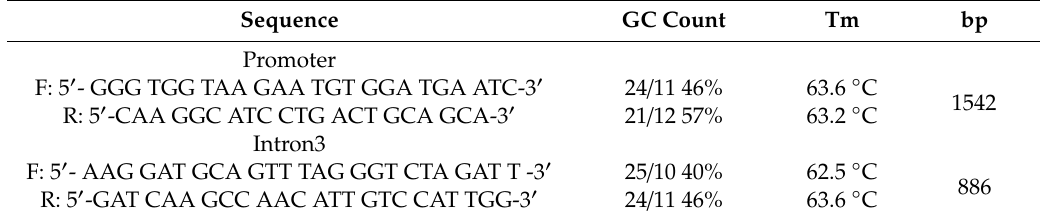
Table 1. The CD28 primers used in this study. F: forward primer; R: reverse primer. Sequence GC Count Tm bp